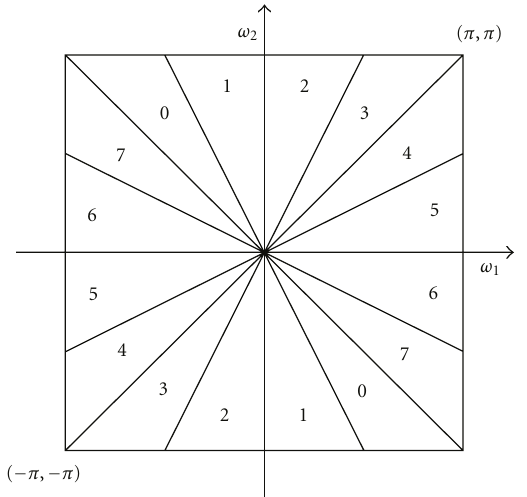
Figure 3: Frequency partitioning ( k = 3, 2 k = 8 we dge-shaped frequency subbands) [12].